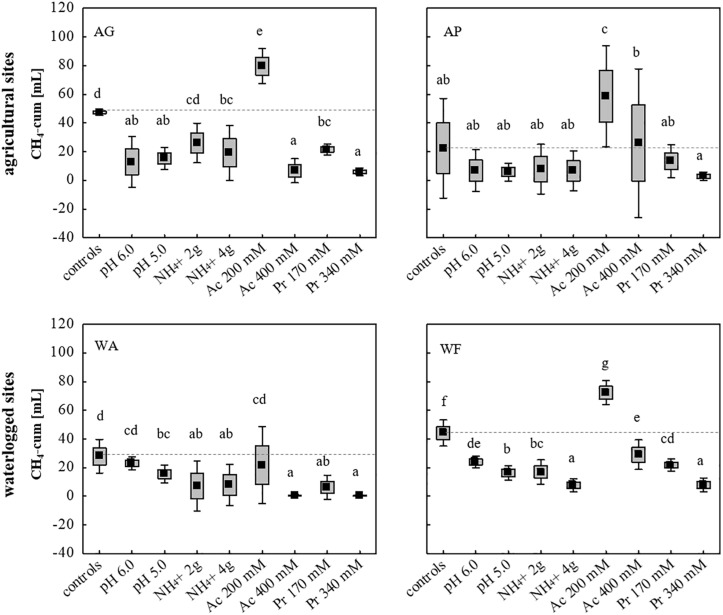
Cumulative CH4 production [mL] in 14 days of anaerobic incubation using two agricultural (AG, AP) and two waterlogged soils (WA, WF) as inoculum for anaerobic digestion. Boxes: mean ± SE, Whisker: mean ± 0.95 confidence interval, n = 9. Letters indicate statistically significant differences (p < 0.05) compared with the controls (indicated also by dashed lines). Study sites: AG, agricultural grassland; AP, agricultural pastureland; WA, waterlogged alluvial soil; WF, waterlogged fen. Stress (low and high load): Ac, acetate; Pr, propionate.